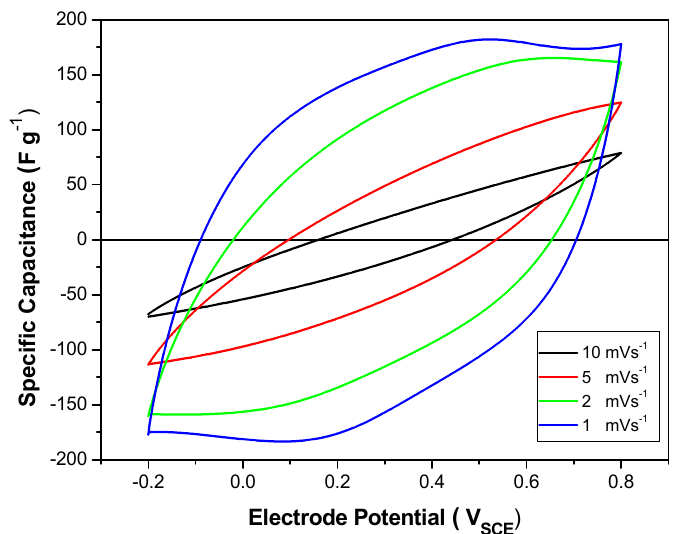
Figure 6. Cyclic voltammogram of a composite (c(RF@F)) electrode in 1 M H 2 SO 4 . Scan rate = see insert.